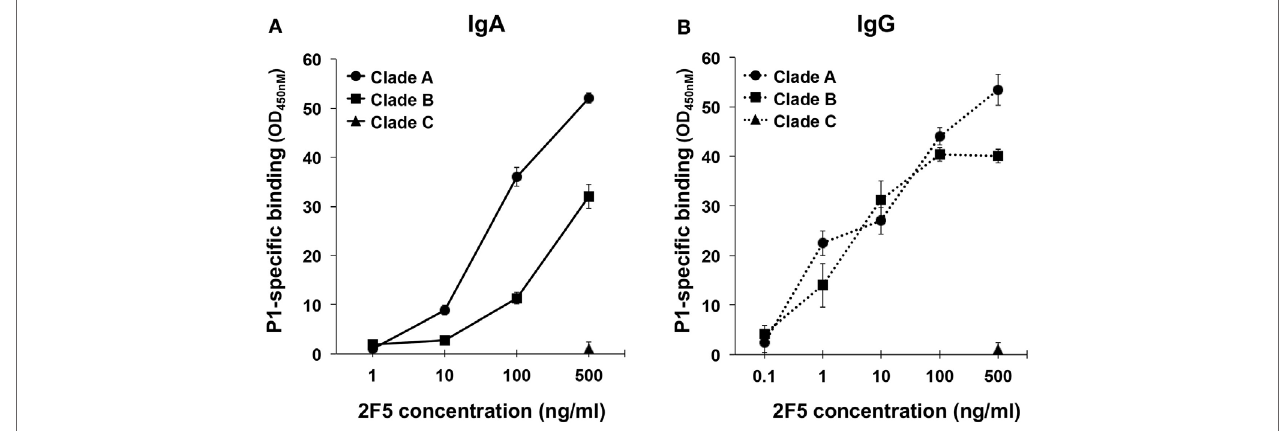
FigUre 1 | 2F5-IgA and 2F5-IgG bind to P1 Clades A and B in a dose-dependent manner. The specificity of (a) 2F5-IgA (solid line) and (B) 2F5-IgG (dotted line) for P1 Clade B (square), Clade A (circle), and Clade C (triangle) was evaluated by ELISA. Mouse anti-human kappa light chain was used for direct comparison of both 2F5 isotypes. Specific binding (OD, 450 nm) is plotted as a function of 2F5 antibody (Ab) concentration (ng/ml). No binding was detected for the irrelevant IgA or IgG used as negative controls (OD 450 nm: < 0.1). Values represent mean ± SEM, derived from three independent experiments performed in duplicate.